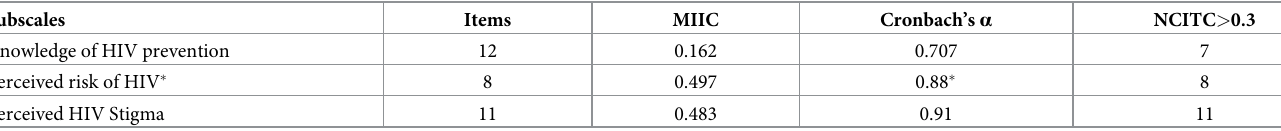
Table 1. Internal consistency and measurement properties of